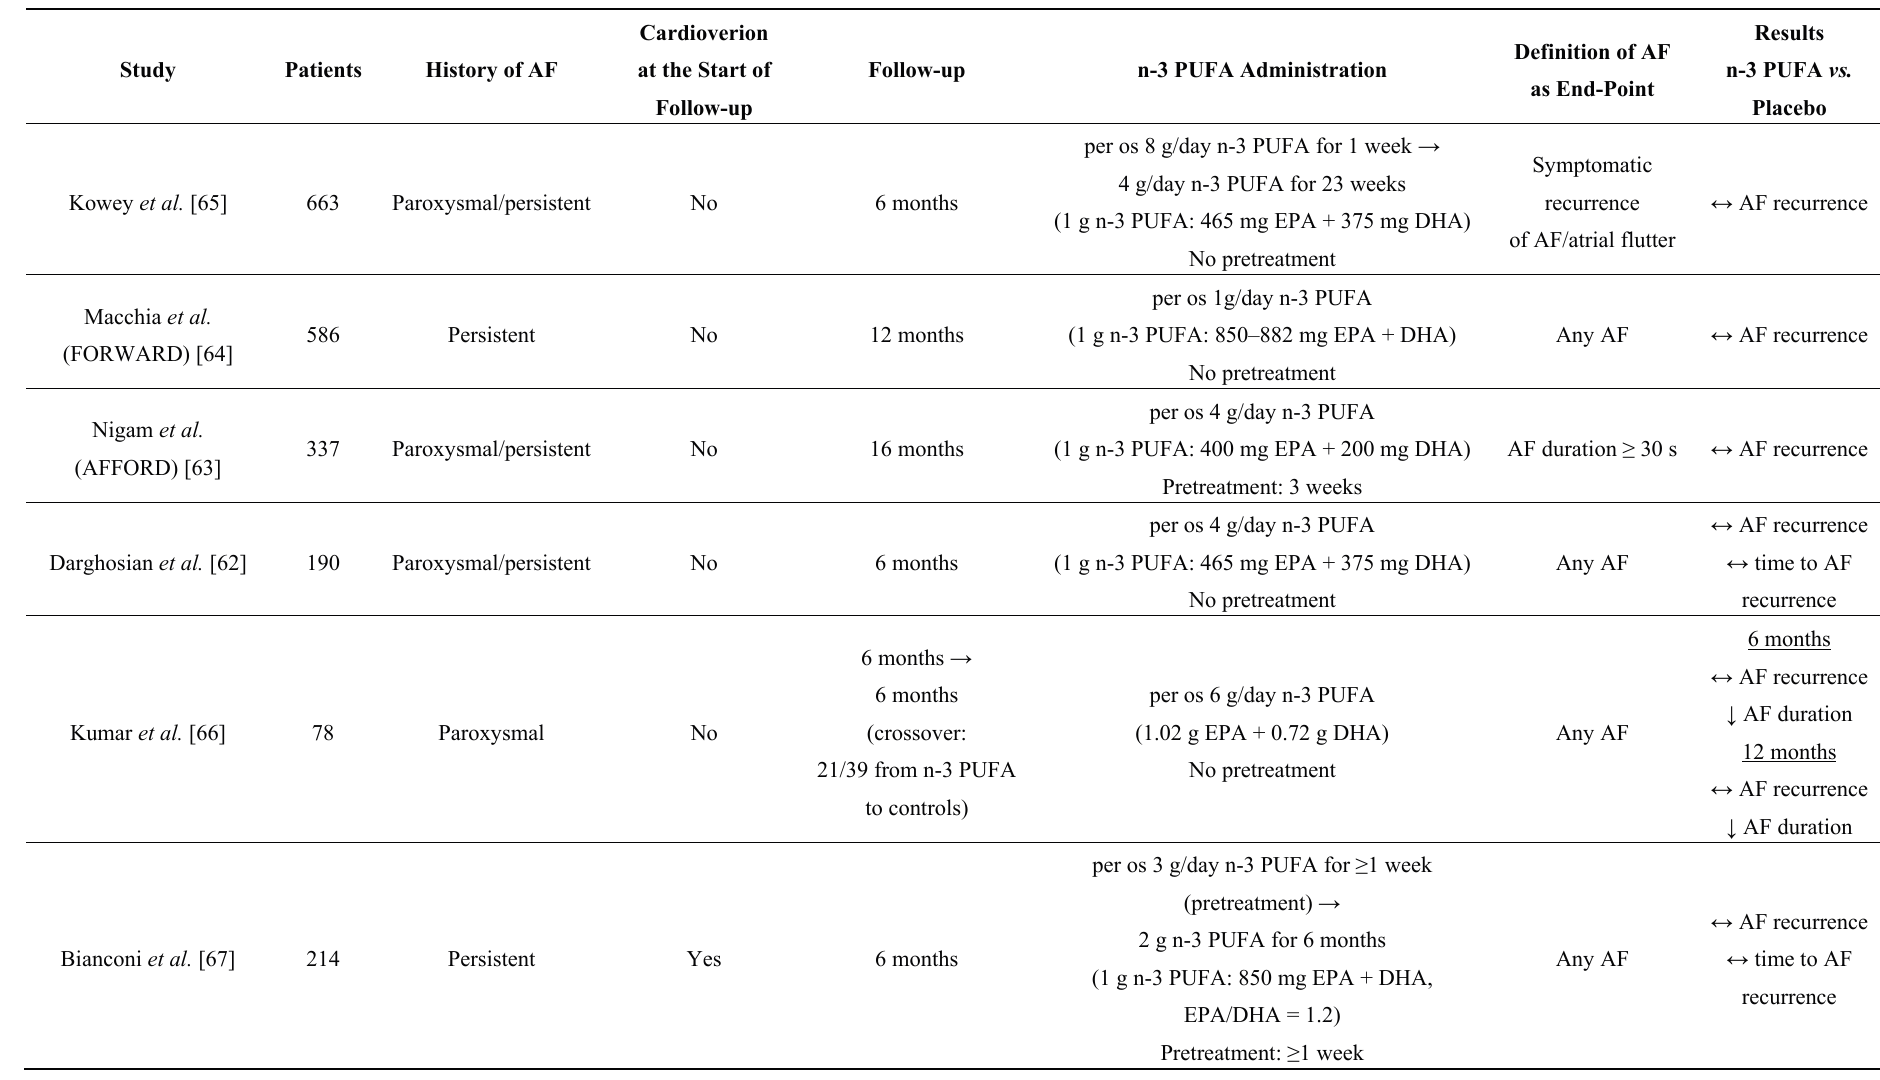
Table 2. The impact of n-3 PUFA supplementation on the incidence of atrial fibrillation (AF) in patients with a history of